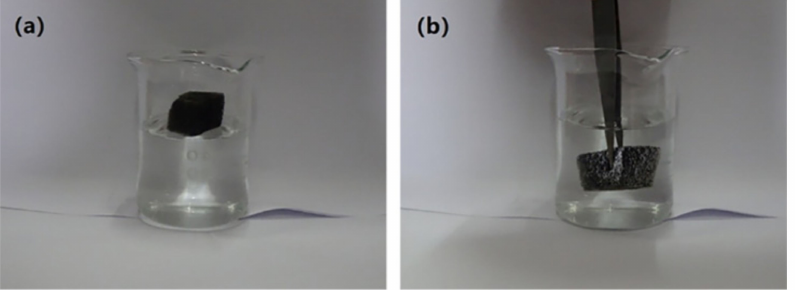
Figure 7. ( a ) Optical image of OTS-CNTs/PU sponge floating on the water surface; ( b ) optical image of OTS-CNTs/PU sponge immersed in a water bath under external